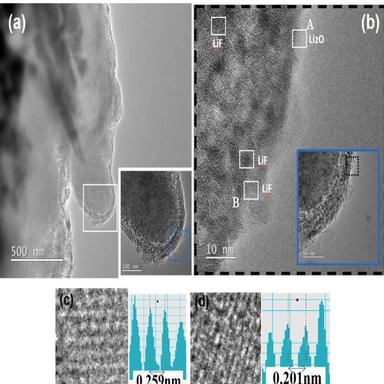
TEM images taken after 2cycles of the CV process. (a) Low magnification TEM image with the formation of an outer peer layer, SEI, on the Li-C. (b) High magnification TEM image of the formed SEI. (c, d) Lattice images showing the Li2O and LiF on the SEI layer with the intensity profiles, respectively.